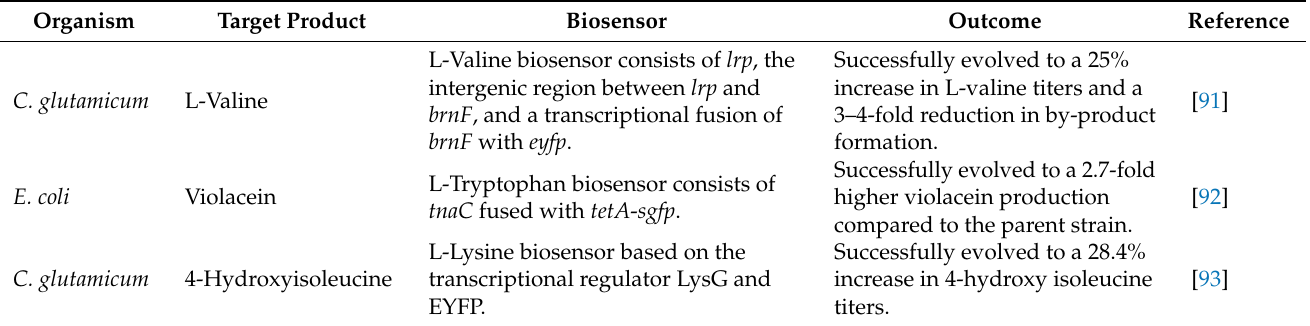
Table 5. Biosensors used for ALE towards the increase in product